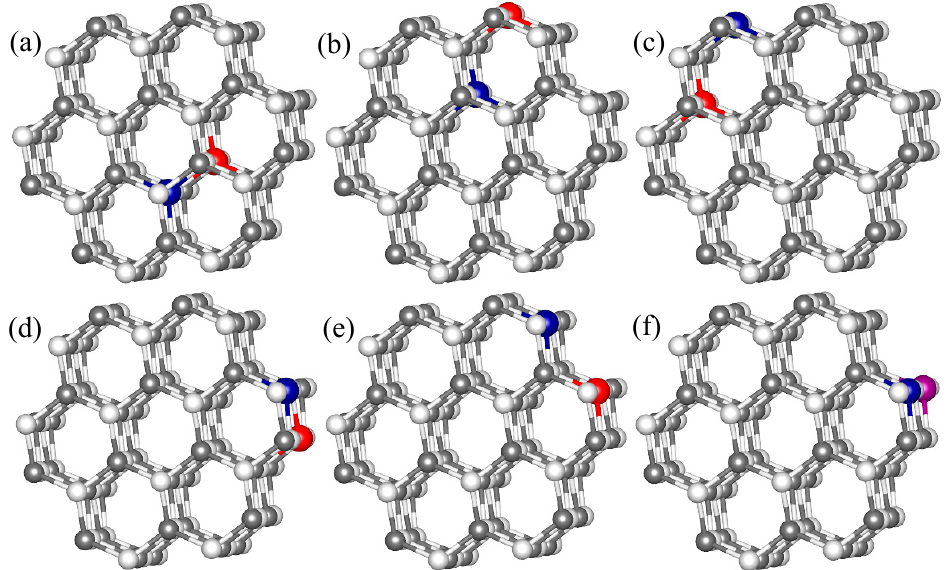
Figure 2. ZnO nanowire coupling model (white and light black represent O and Zn atoms, while blue and red represent Co and Mn atoms) ( a ) Configuration I; ( b ) Configuration II; ( c ) Configuration III; ( d ) Configuration IV; ( e ) Configuration V; ( f ) Configuration VI.